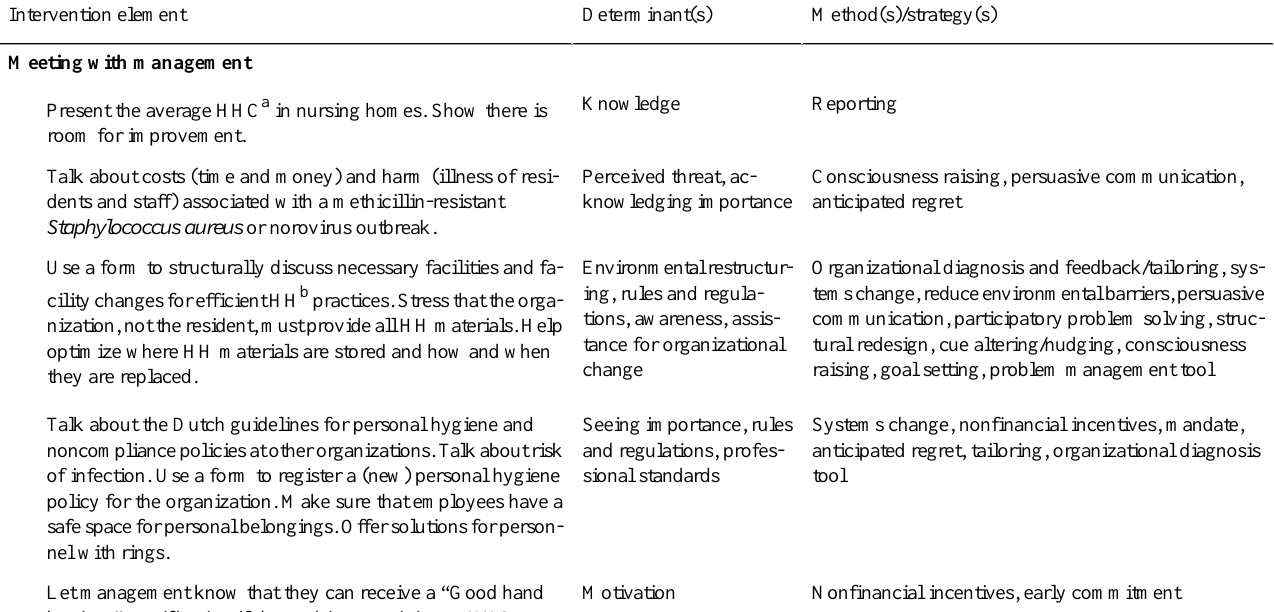
Table 1. Intervention mapping for HANDSOME: using determinants and methods to develop the strategy for intervention